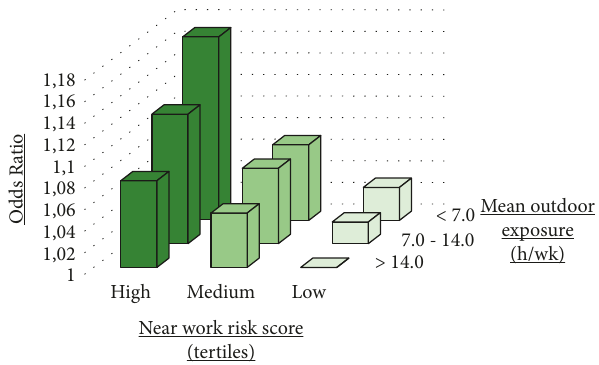
Figure 1: Odds ratios for near activity risk and the mean outdoor time on myopia at the age of 9 years. Near activities risk tertiles represent the combined risk of the computer use, reading, and reading distance. The outdoor time was classified into 14 hours per week. The subset with low near risk and per week of outdoor exposure was the reference subset (adapted from the study by Enthoven et >